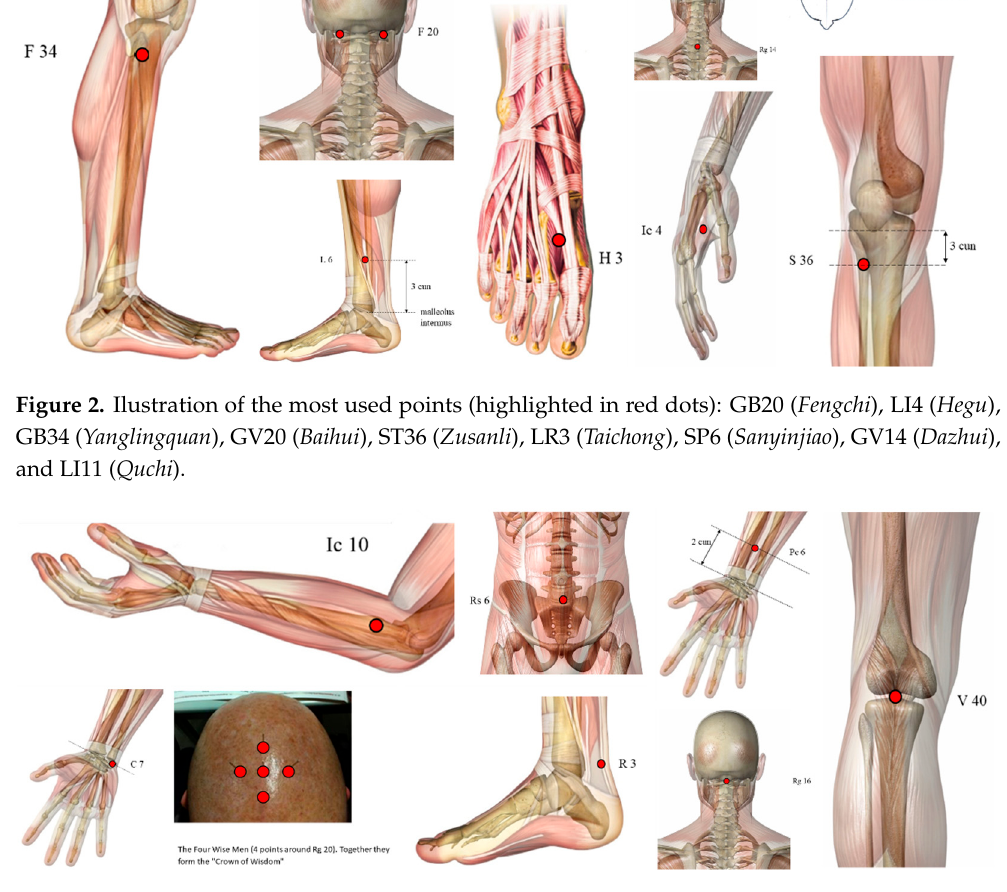
Figure 3. Illustration of other points used (highlighted in red dots): GV16 ( Fengfu ), CV6 ( Qihai ), KI3 ( Taixi ), LI10 ( Shousanli ), BL40 ( Weizhong ), PC6 ( Neiguan ), HT7 ( Shenmen ). Some acupoints (Figure 4) such as TE5 ( Waiguan ), EX-HN-1 ( Sishencong ), BL23 ( Shenshu ), BL18 ( Ganshu ), ST32 ( Futu ), GB38 ( Yangfu ), GB31 ( Fengshi ) and GV24 ( Shenting ) were used only by one study.